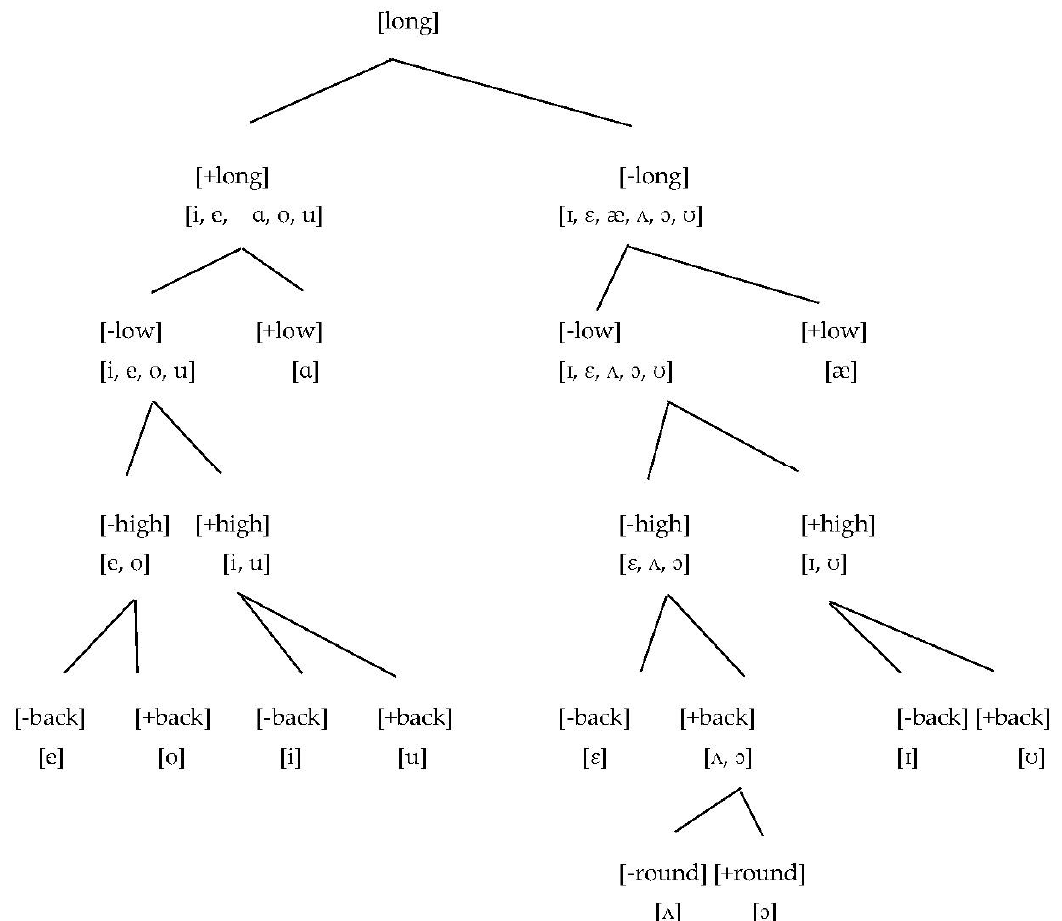
Figure 10. The Arabic contrastive hierarchy applied to English vowels.